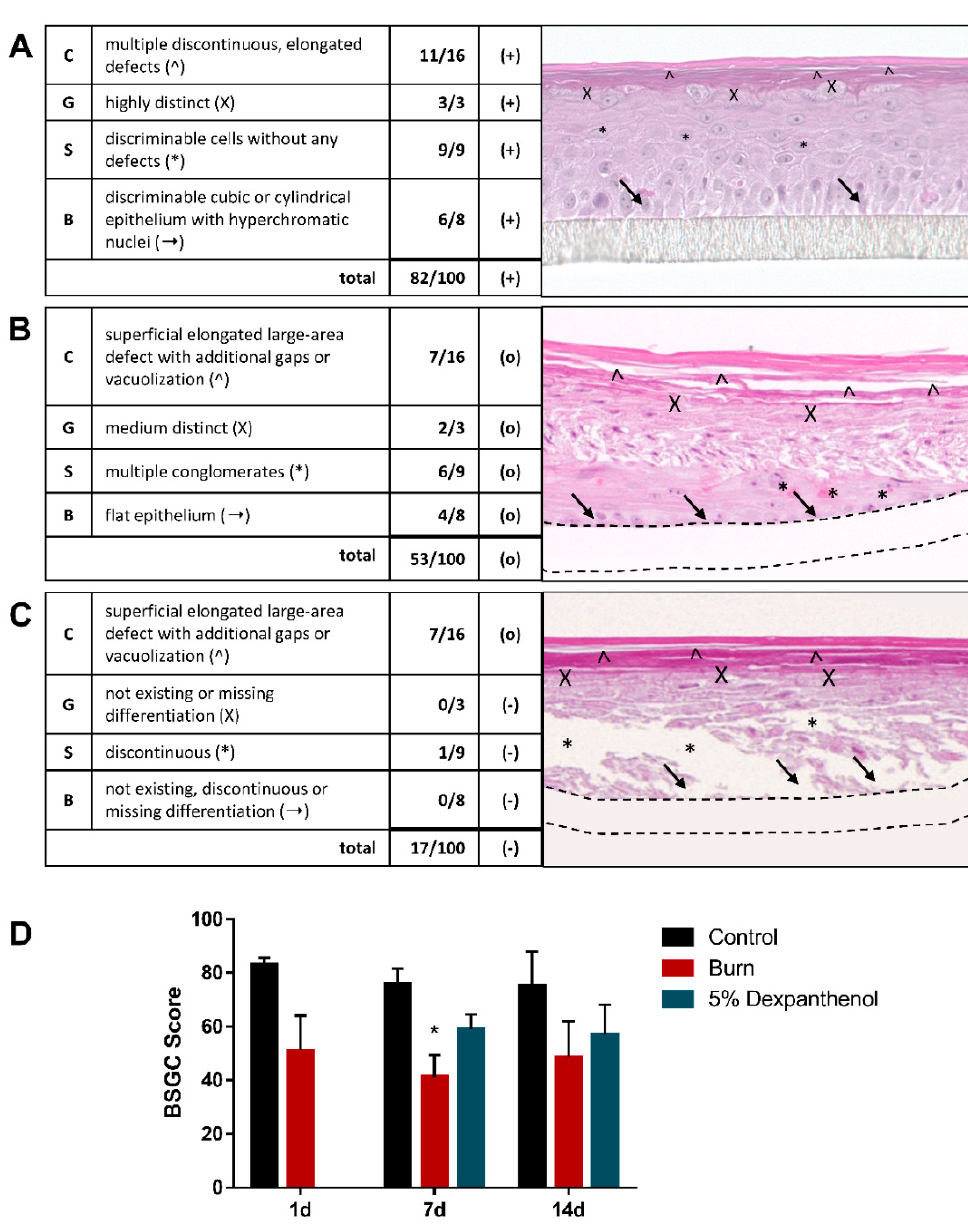
Figure 4. Evaluation of models using the BSGC Score. ( A – C ) Exemplary evaluation of models with different quality using the BSGC Score. Layers of the epidermis are evaluated from apical to basal layer, according to their physiologicaol order (Str. Corneum/C; Str. Granulosum/G; Str. Spinosum/S; Str. Basale/B). Defects or attributes are highlighted by corresponding symbols (^, X, *, → ). ( A ) Exemplary scoring of a good model (+) with: discontinuous defects of the stratum corneum (^); a highly distinct stratum granulosum (X); no defects in the stratum spinosum (*); a cubic epithelium with hyperchromatic nuclei in the stratum basale ( → ). ( B ) Exemplary scoring of a satisfactory model (o) with a large area defect with additional gaps in the stratum corneum (^); medium distinct stratum granulosum (X); multiple conglomerates in the stratum spinosum (*); a flat epithelium in the stratum basale ( → ). ( C ) Exemplary scoring of a deficient model (-) with: a large area defect with additional gaps in the stratum corneum (^); no differentiation of the stratum granulosum (X); a discontinuous stratum spinosum (*); a missing stratum basale ( → ). ( D ) Evaluation of control models and of the wound edge of burned models, and models that were burned and treated with 5% dexpanthenol on day 1, 7 and 14 after wounding. (3 biological replicates in independent test runs with 3 sections from 1 technical replicate each; mean values ± SD; Kruskal-Wallis test with Dunn’s multiple comparisons test, * p < 0.05 compared to the control).